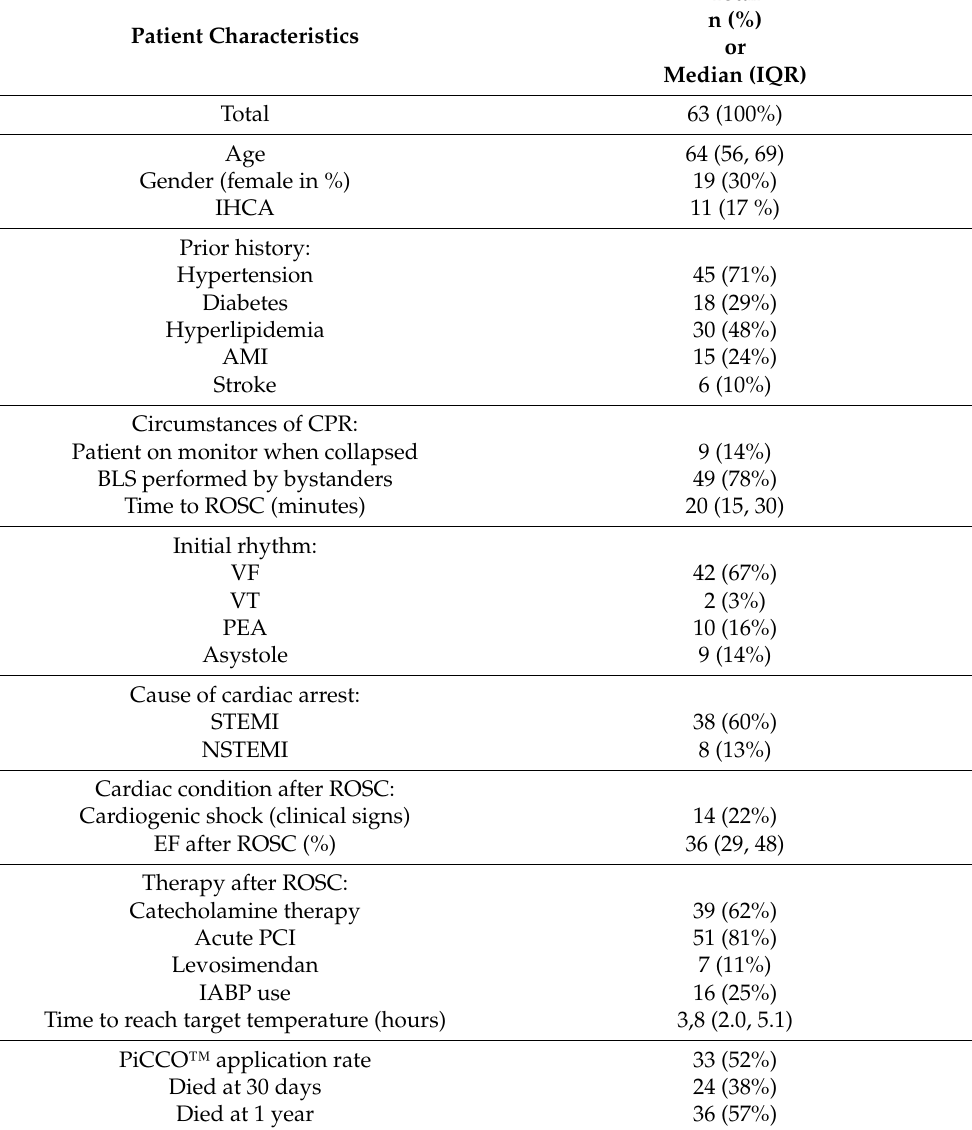
Table 1. Patient characteristics. AMI: acute myocardial infarction; BLS: basic life support; CPR: cardiopulmonary resuscitation; EF: ejection fraction; IABP: intra-aortic balloon pump IHCA: in- hospital cardiac arrest; IQR: interquartile range; MI: myocardial infarction; n: number of